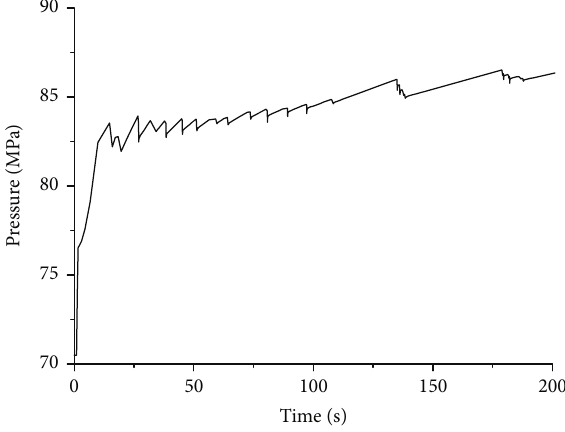
Figure 14: Pressure curve at the NF approaching angle of 30 ° and stress anisotropy coe ffi cient of